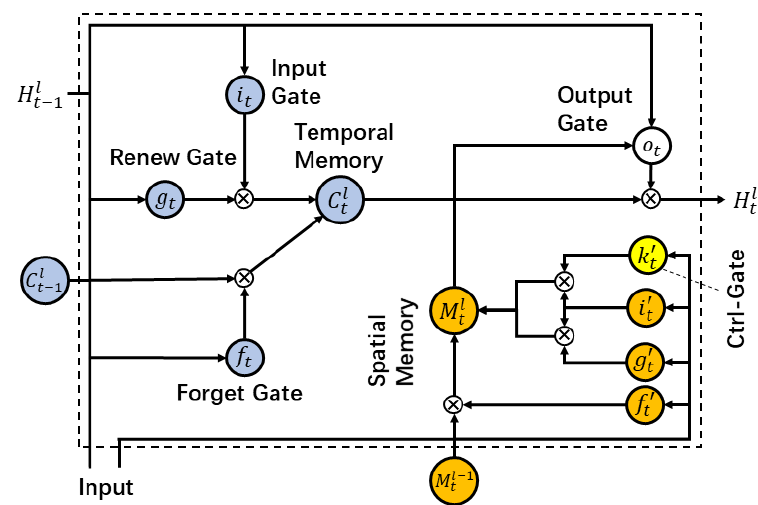
Figure 2. Units of